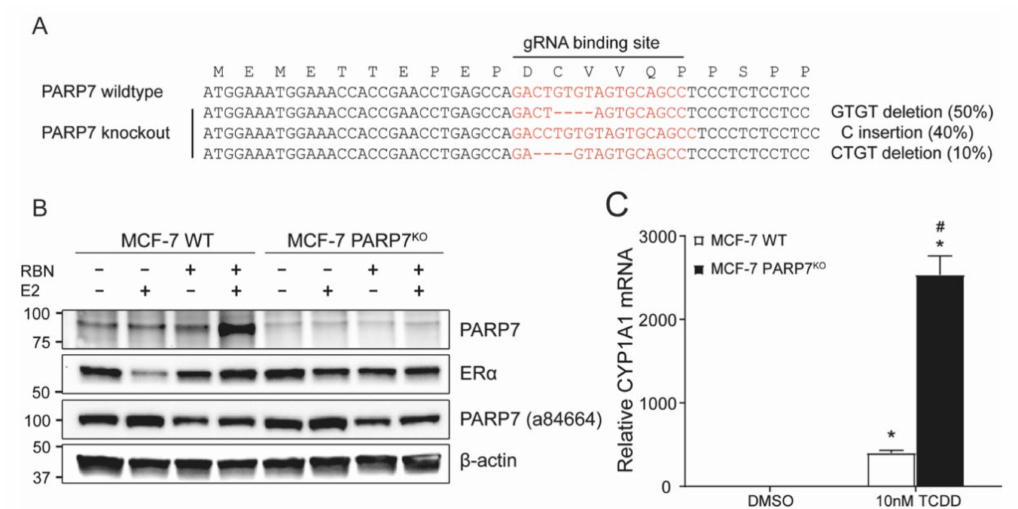
Figure 3. Confirmation of MCF-7 PARP7 knockout cells. ( A ) Schematic representation of the gRNA binding site, showing insertions/deletions resulting in frameshift mutations. The deleted bases are represented as dashes. The data are from 45 independent sequences. ( B ) PARP7 is not detected in the PARP7 KO cells when blotting the membrane with our lab generated anti-PARP7 antibody. MCF-7 wildtype and PARP7 KO cells were treated with DMSO, E2 or/and RBN-2397 for 24 h. Membranes were blotted with lab generated anti-PARP7, anti ER α and anti-PARP7 (Abcam; ab84664). Blotting with anti-PARP (ab84664) resulted in bands across all lanes at approximately 100 kDa. ( C ) Loss of PARP7 increases expression of AHR target gene CYP1A1. MCF-7 wildtype and PARP7 KO cells were treated with 10 nM TCDD for 24 h. Relative mRNA levels of CYP1A1 was determined with RT-qPCR. Significant differences ( p < 0.05) compared to DMSO are denoted with *, and differences due to PARP7 are denoted with the hash mark #. Data are shown as means ± S.E.M. for three independent